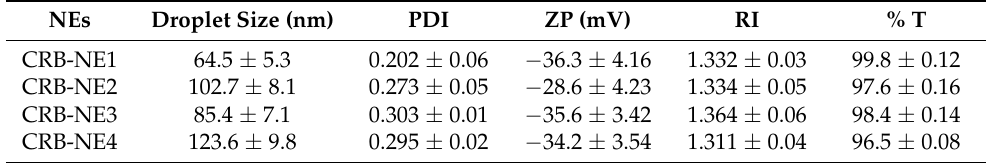
The average droplet size, PDI, and ZP of CRB loaded NEs (CRB-NE1-CRB-NE4) were measured in the range from 64.5 ± 5.3 to 123.6 ± 9.8 nm, 0.202 ± 0.06 to 0.303 ± 0.01, and − 28.6 ± 4.23 to − 36.3 ± 4.16 mV, respectively (Table 1). Among the all developed NEs (CRB-NE1-CRB-NE4), CRB-NE1 had the minimum droplet size (64.5 ± 5.3 nm) with PDI (0.202 ± 0.06) and the highest ZP ( − 36.3 ± 4.16 mV). The highest ZP values ( ± >30 mV) indicate a stable nanoemulsion [21]. The mean values of RI’s for CRB-NE1-CRB-NE4 were measured in the range from 1.302 ± 0.03 to 1.411 ± 0.04. The least RI’s value for CRB-NE1 (1.302 ± 0.03) was measured; it may be the lowest content of oil in the formulation [22,23]. The highest % T was observed for CRB-NE1, indicating a transparent Table 1. Physicochemical properties of developed CRB loaded NEs (CRB-NE1-CRB-NE4). NEs Droplet Size (nm) PDI